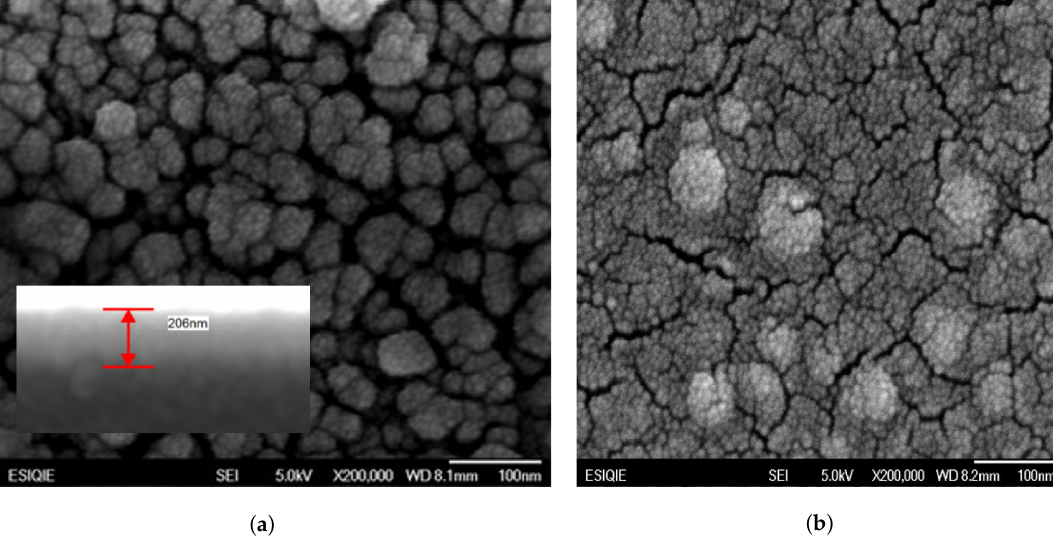
Figure 3. SEM images of NiO ( F ) before and after ozonation (60 min of treatment). Insert Figure 2a presents the cross-sectional image of the NiO ( F ) : ( a ) NiO ( F ) , ( b ) O 3 - NiO ( F )